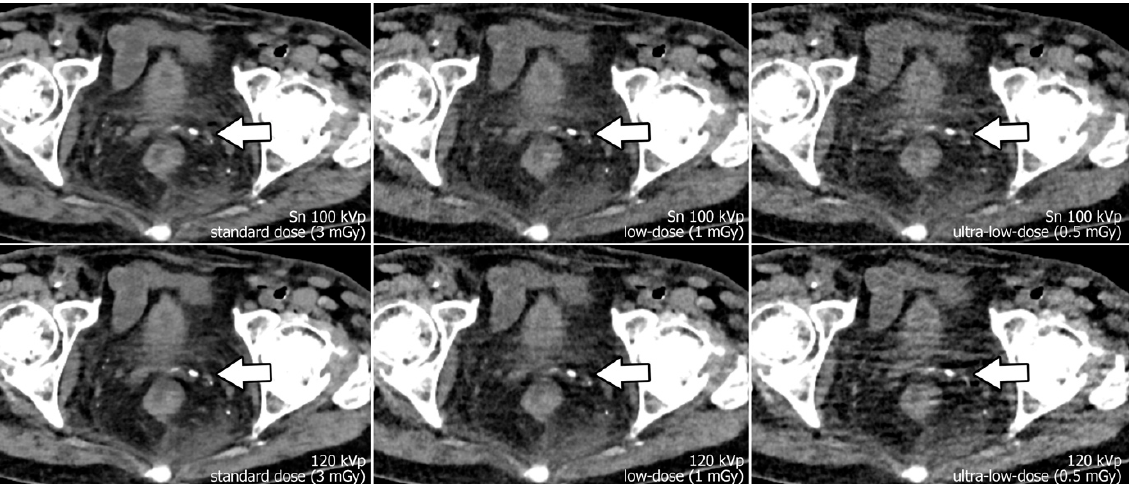
Figure 1. Axial view of the left distal ureter (arrow). Note the impaired image quality due to hypodense streak artifacts in polychromatic scans at 120 kVp (lower row), especially with ultra-low radiation dose. (The arrow marks the left ureter with an adjacent phlebolite.)